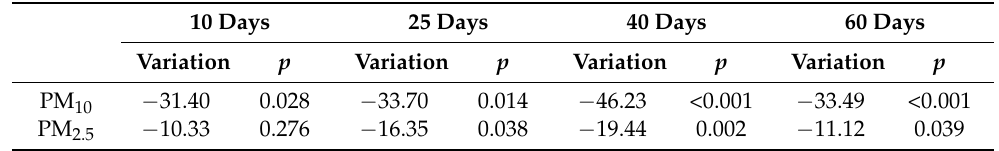
Table 3. Variation of daily PM 10 and PM 2.5 concentrations after the different duration of the home office order by ITS